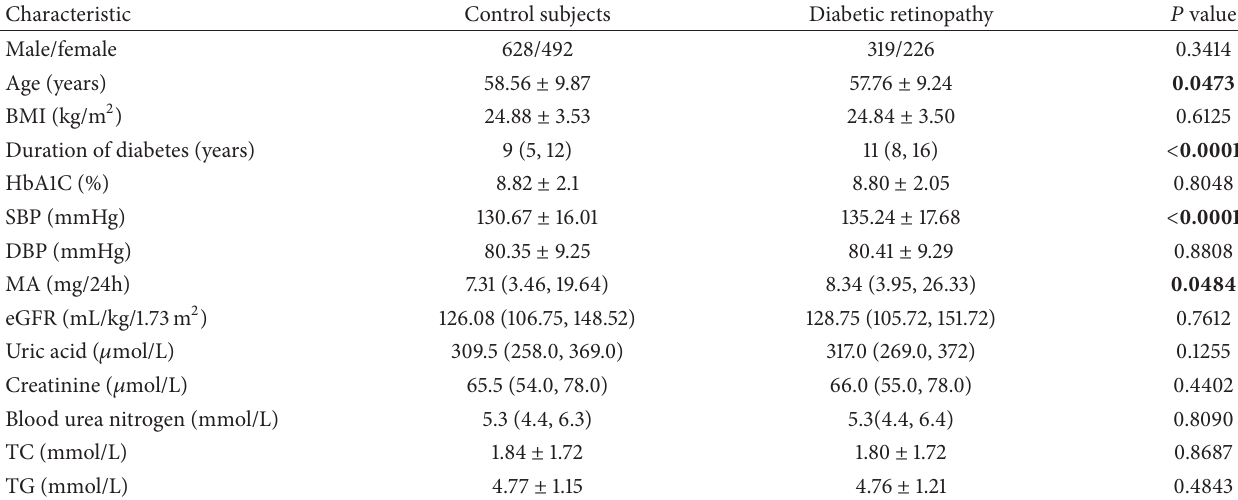
Table 2: The clinical characteristics of diabetic retinopathy group and control